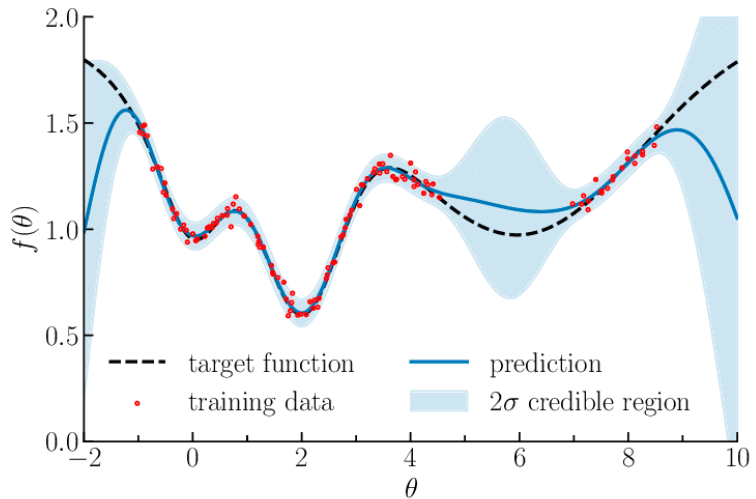
Figure 3. Illustration of the Gaussian process in a one-dimension case for the target function 𝑓: Θ → 2 − 𝑒𝑥𝑝(cid:4670)−(𝜃 − 2) (cid:2870) (cid:4671) − 𝑒𝑥𝑝(cid:4670)−(𝜃 − 6) (cid:2870) /10(cid:4671) − 1/(𝜃 (cid:2870) + 1) (dashed line). The training set plus Gaussian noise with an RMS deviation of 0.03 is shown by the red dots. The light blue line shows the mean value predicted by the Gaussian process, and the painted area around it is the 2 σ error. The illustration is from [16].